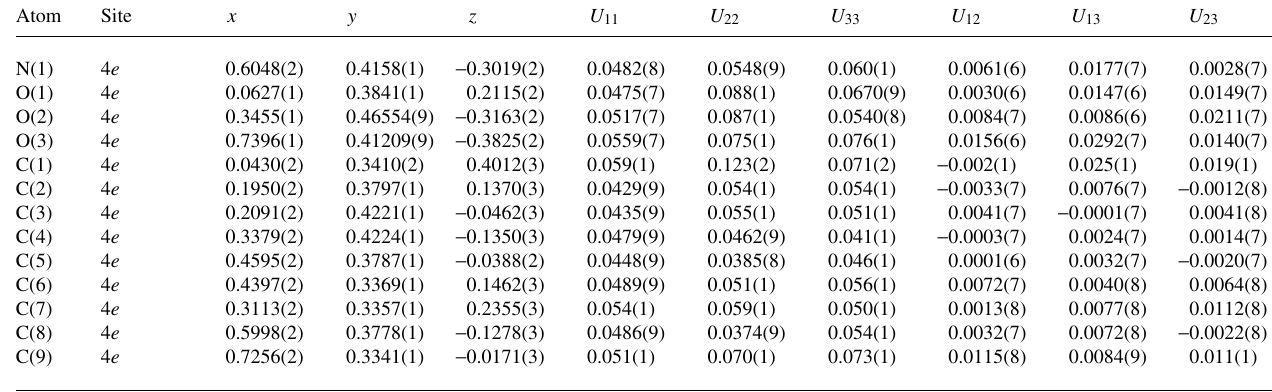
Table 3. Atomic coordinates and displacement parameters (in Å 2 ) .